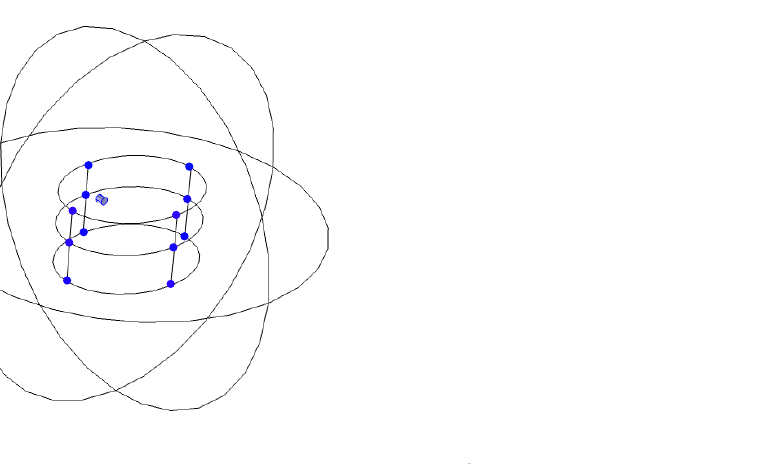
Figure 4. Proposed simulation setup in COMSOL Multiphysics ® 5.4. The 12 sensors and the magnet are highlighted in blue. Moreover, the spherical computational domain is